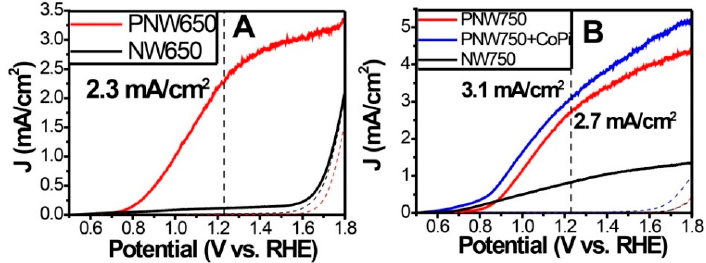
Figure 10. PEC performance of P-doped hematite photoanode. ( A ) J-V curves for the P-doped hematite anodes annealed at 650 ° C under simulated AM 1.5 G illumination (solid lines) and in the dark (dash lines) in 1 M NaOH at a scan rate of 50 mV/s; ( B ) J-V curves for the P-doped hematite anodes annealed at 750 ° C and “Co-Pi”-loaded P-doped hematite anode. Adapted with permission from [33]. Copyright 2015 Royal Society of Chemistry.